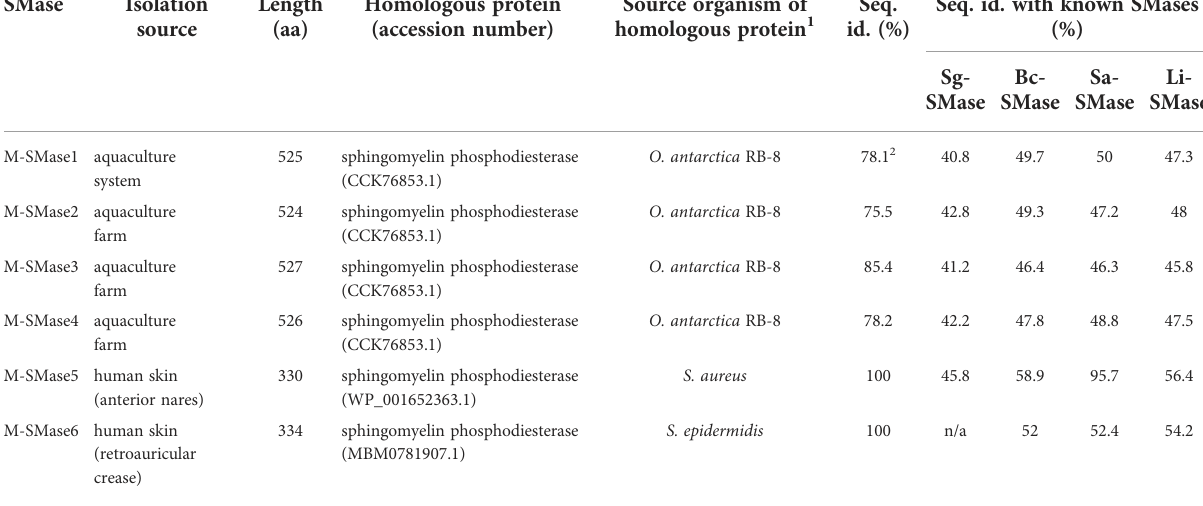
TABLE 2 Putative SMases identi fi ed from human skin and marine aquaculture microbiomes.